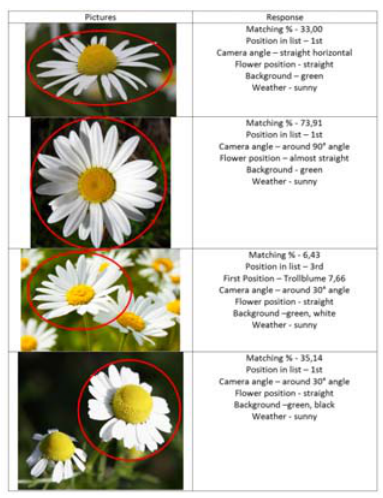
Figure 25: Image acquisition examples and possible effects (Source: Shohrab